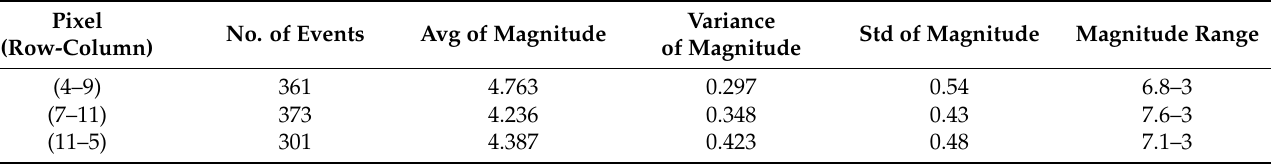
Table 1. Statistics of the events lying in the three selected pixels (Avg is average, Std is the standard deviation, No. is the number).